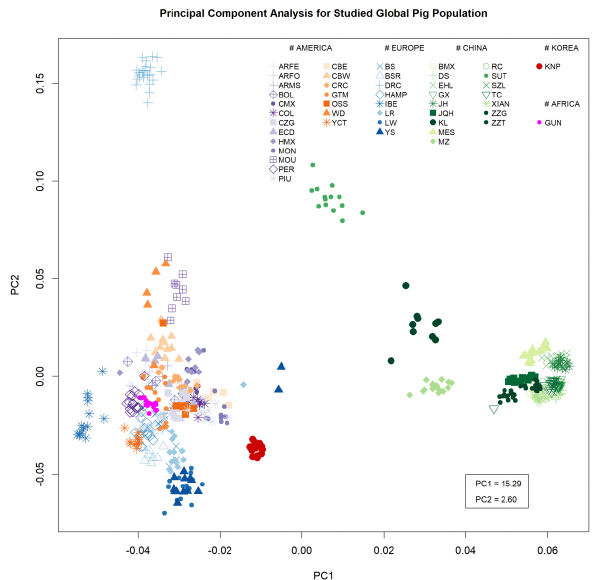
Figure 1. Genetic mapping based on principal component analysis: The variance explained by each component is shown in the bottom right as a percentage. (Argentina Feral (ARFE), Argentina Formosa Semi Feral (ARFO), Argentina Misiones Creole (ARMS), Bamaxiang (BMX), Bolivia Creole (BOL), Berkshire (BS), Bisaro (BSR), Cuba Eastern Creole (CBE), Cuba Western Creole (CBW), Mexico Cuino (CMX), Colombia Creole (COL), Costa Rica Creole (CRC), Colombia Zungo (CZG), Duroc (DRC), Dongshan (DS), Ecuador Creole (ECD), Erhualian (EHL), Guatemala Creole (GTM), Guinea Hog (GUN), Ganxi (GX), Hampshire (HAMP), Mexico Hairless (HMX), Iberian (IBE), Jinhua (JH), Jiangquhai (JQH), Kele (KL), Korean Native (KNP), Landrace (LR), Large White (LW), Meishan (MES), Brazil Monteiro (MON), Brazil Moura (MOU), Min (MZ), Ossabaw (OSS), Peru Creole (PER), Brazil Piau (PIU), Rongchang (RC), Sutai (SUT), Shaziling (SZL), Tongcheng (TC), White Duroc (WD), Xiang Pig (XIANG), Yucatan (YCT), Yorkshire (YS), Tibetan Gansu (ZZG), Tibetan Tibet (ZZT).) 3.2. Ancestry Analysis In ancestry cluster analysis (Figure 2), 3 – 10 clusters were derived, where the optimal K-value was 41 (Figure S2). In detail, IBE showed a shared ancestry with all American breeds except White Duroc (WD). The degree of admixture declined with the same ancestry in IBE, with increasing ancestry number. DRC showed a partially shared ancestry with the American breeds and with SUT. Chinese breeds shared a similar ancestry, except for KL, MZ, and SUT. KL and MZ showed a partially shared ancestry with American and European breeds when 8 – 10-cluster solutions were used. SUT